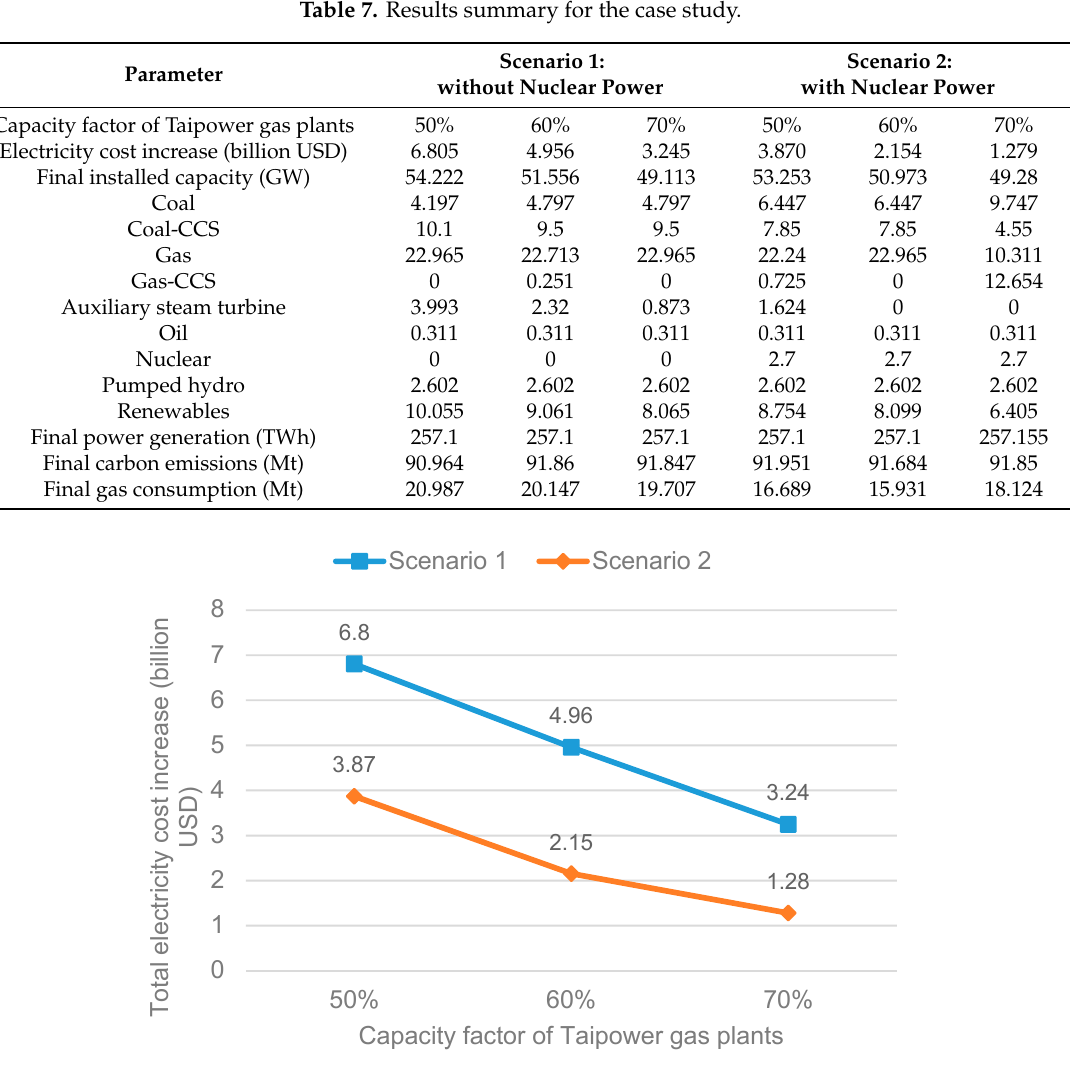
Figure 5. Total cost increase versus the gas plant capacity factor. Table 8. CCS retrofits for the case study.